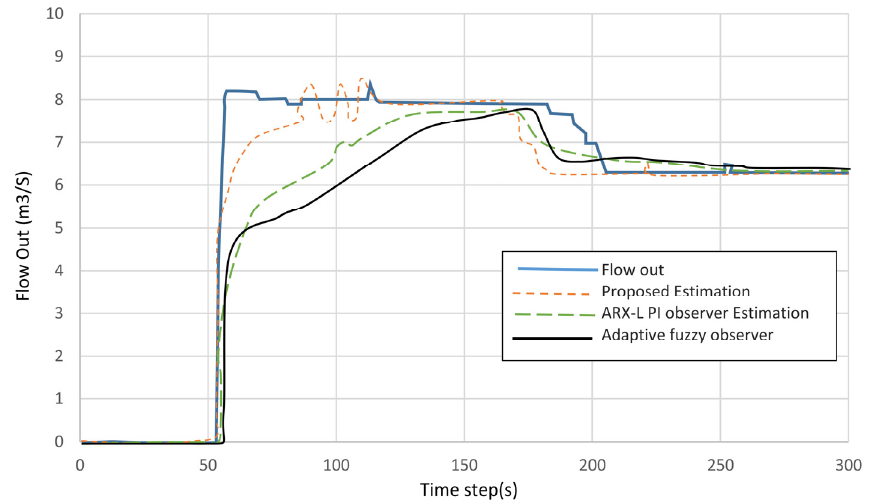
Figure 9. The effectiveness of the proposed technique for fault estimation under fault condition.